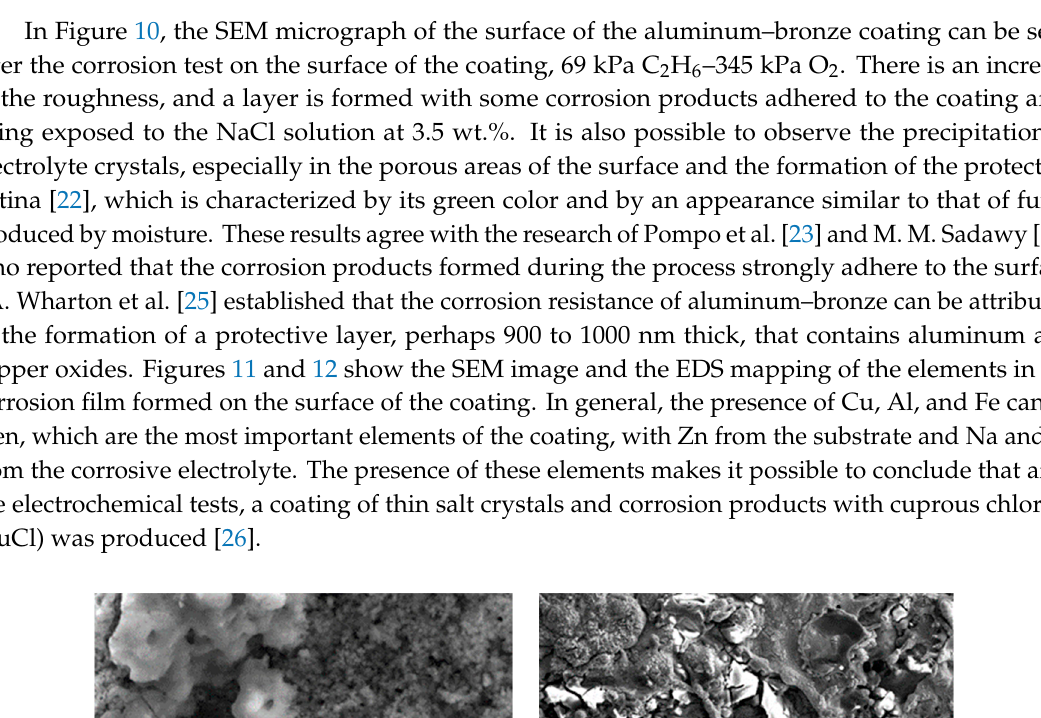
Figure 9. Current density vs. percentage of porosity.